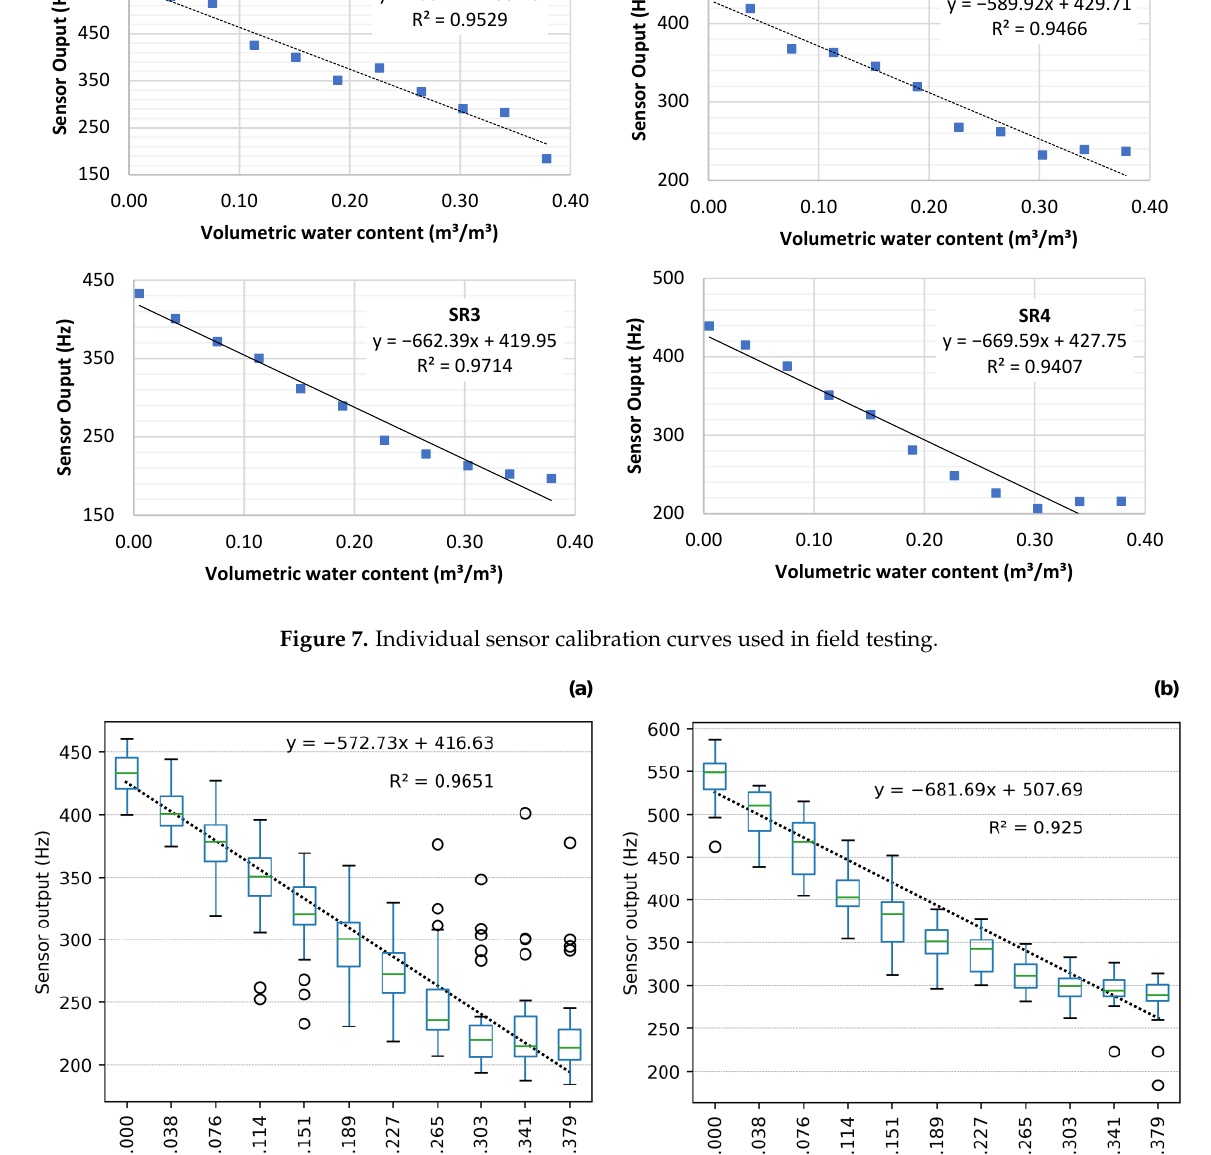
Figure 9. Universal sensor calibration curve. Table 4. Statistical metrics for different calibration methods. Individual